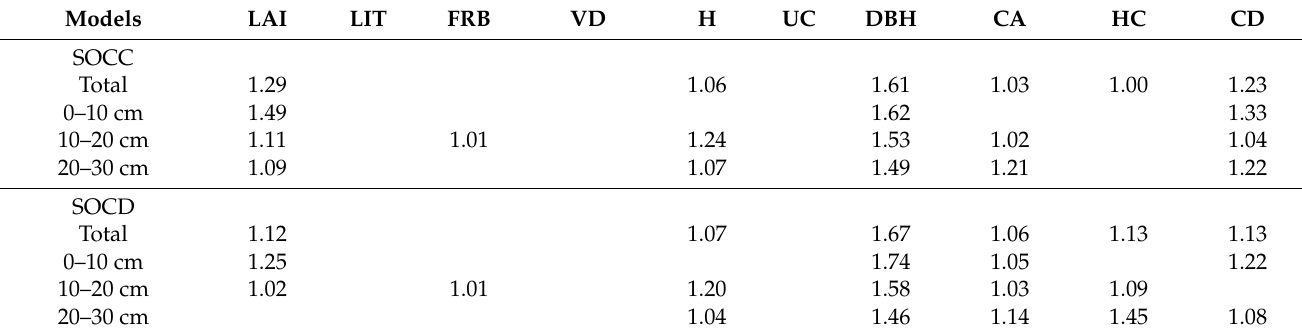
Table 3. The variable importance in projection (VIP) scores of different traits in each model projection. The traits with VIP scores < 1 were culled. Abbreviations: LAI, leaf area index; LIT, semi-decomposed leaf litter; FRB, fine root biomass; H, tree height; UC, under crown height; DBH, diameter at breast height; CA, canopy area; HC, herbaceous vegetation cover; CD, crown